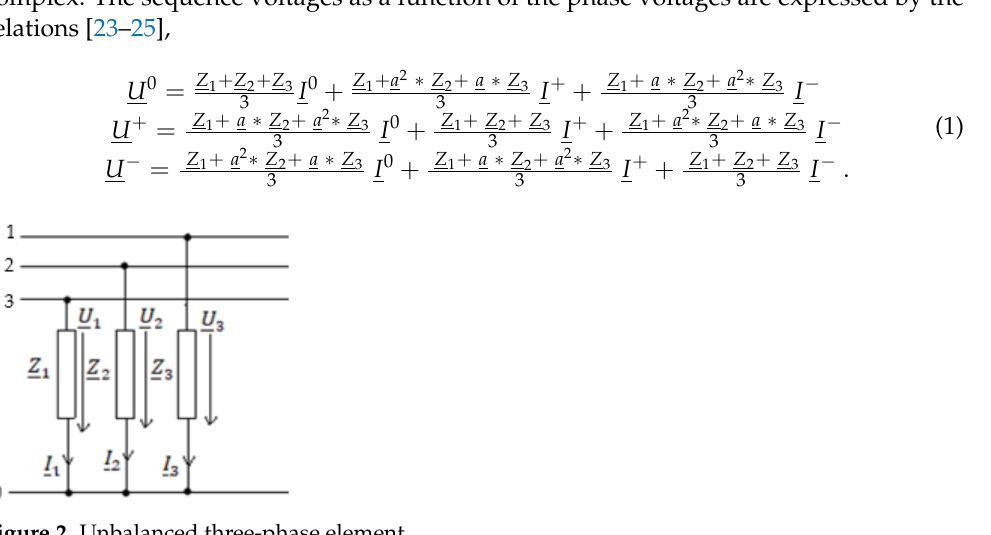
Figure 2. Unbalanced three-phase element.